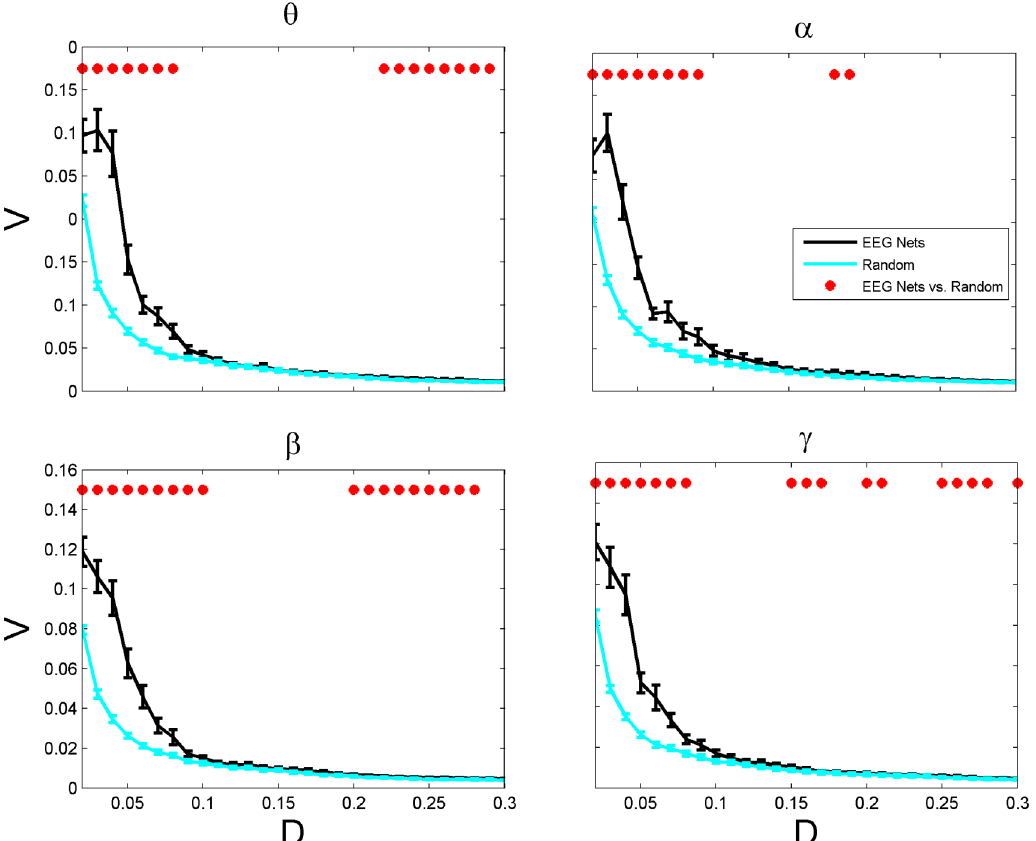
Fig 2. Vulnerability V (as defined in Eqs (3) and (4)) as a function of density in EEG-based brain functional networks and the corresponding randomized versions. Other designations are as Fig 1. doi:10.1371/journal.pone.0135333.g002 PLOS ONE | DOI:10.1371/journal.pone.0135333 August 21,